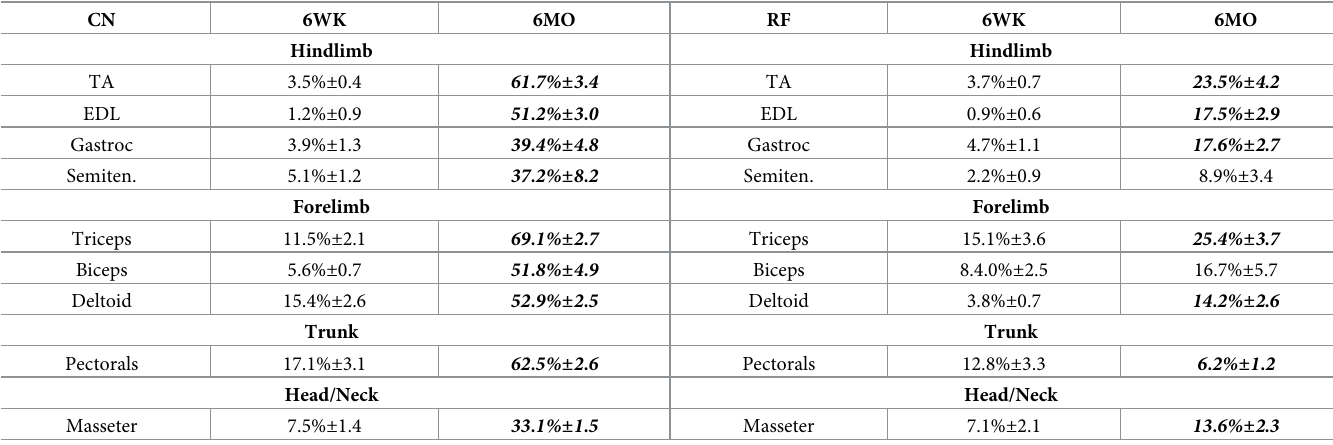
Table 1. Percentage of centranucleation (CN) and revertant fibers (RF) in 6 week (6WK) and 6 month (6MO) old P448Lneo-